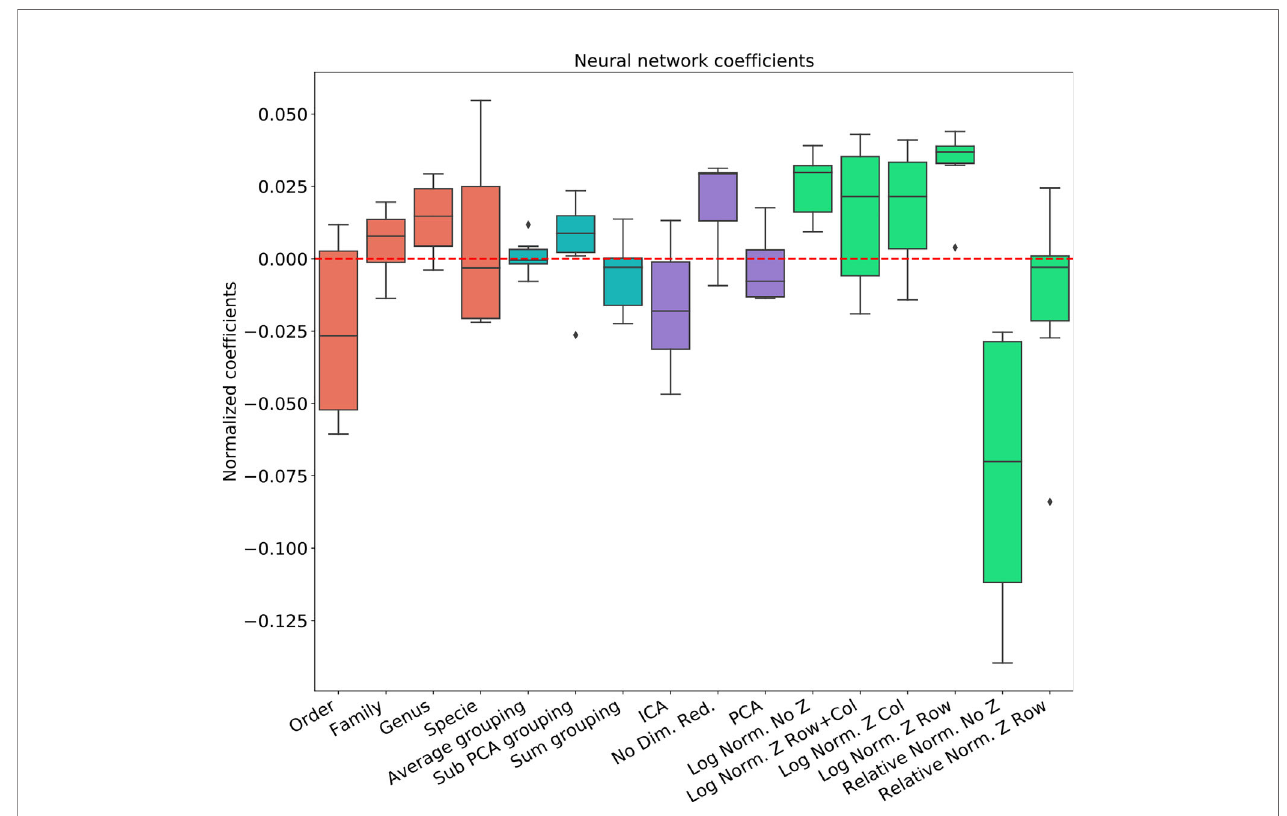
FIGURE 5 | Linear regression coef fi cient for MLP classi fi er.